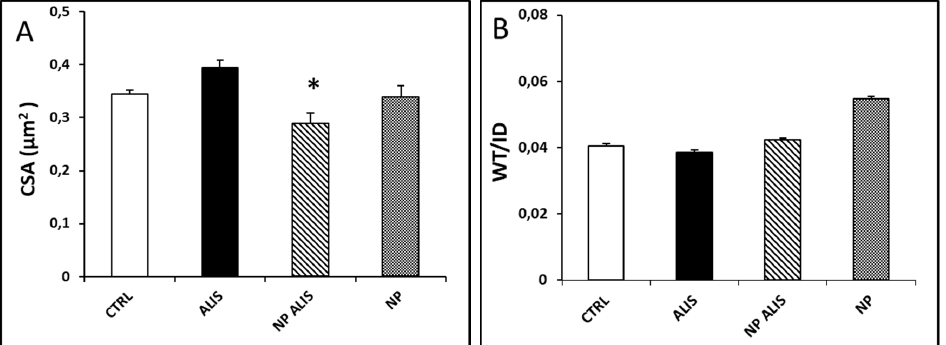
Figure 9. Effect of powdered aliskiren (ALIS), nanoparticle-loaded aliskiren (NP ALIS), and Figure 9. E ff ect of powdered aliskiren (ALIS), nanoparticle-loaded aliskiren (NP ALIS), and